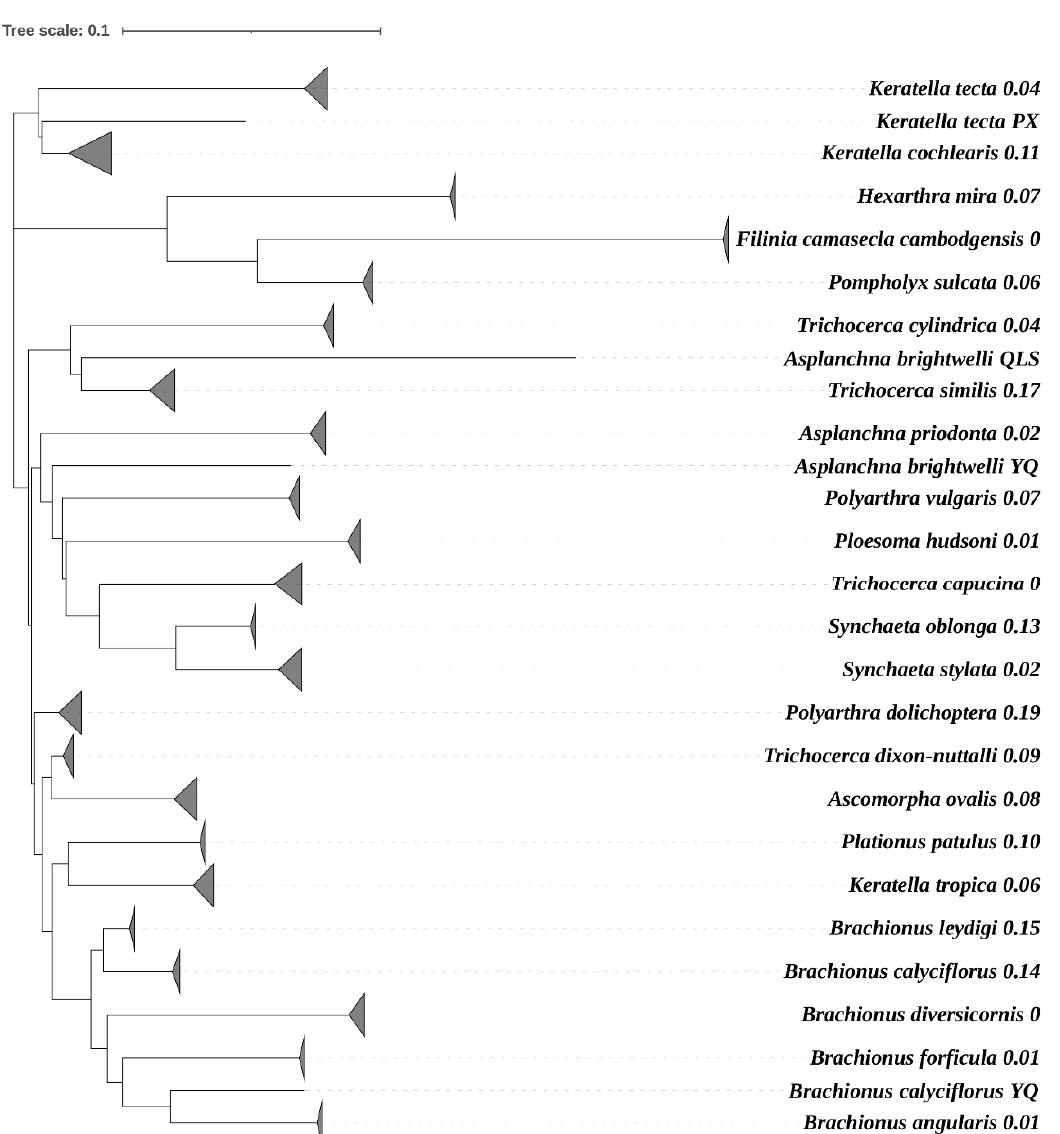
Figure 4. A simplified NJ tree with K2P distance for 24 morphological taxa. The triangle size represents the number of sequences, and the number after the species name is the mean K2P distance. The abbreviations after a species with a single sequence is the acronym of the reservoir name.